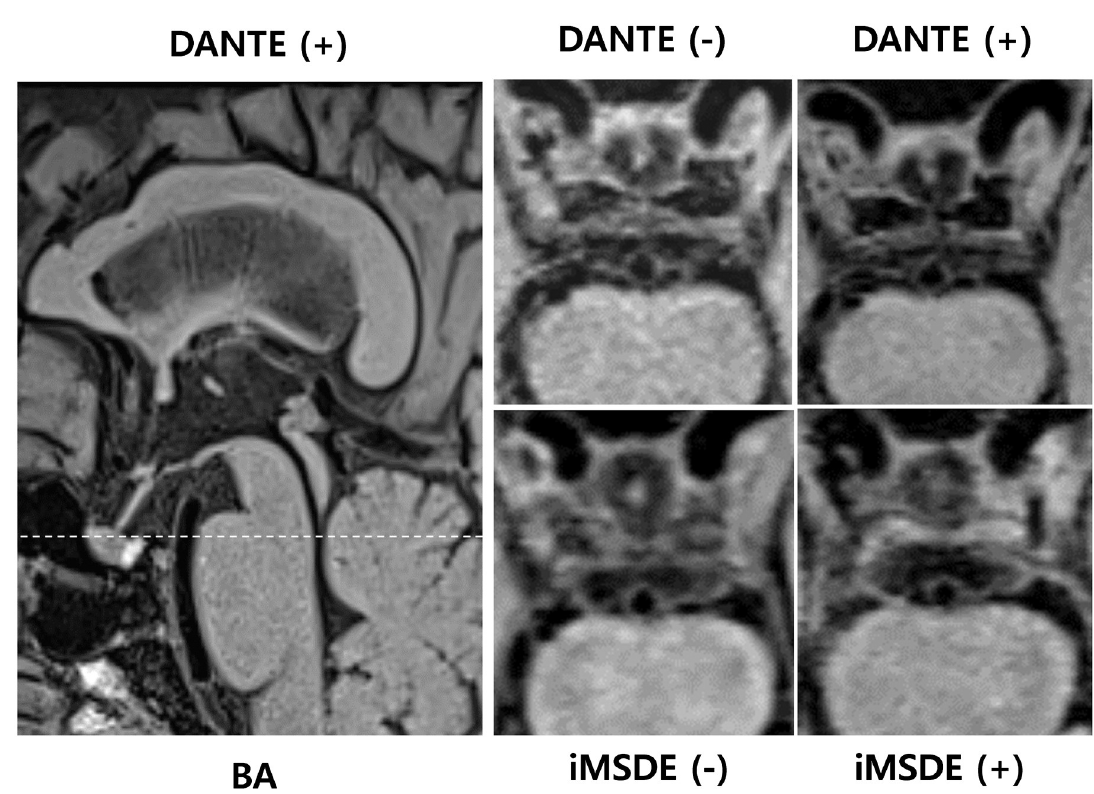
3D T1WI 3D T1WI without iMSDE